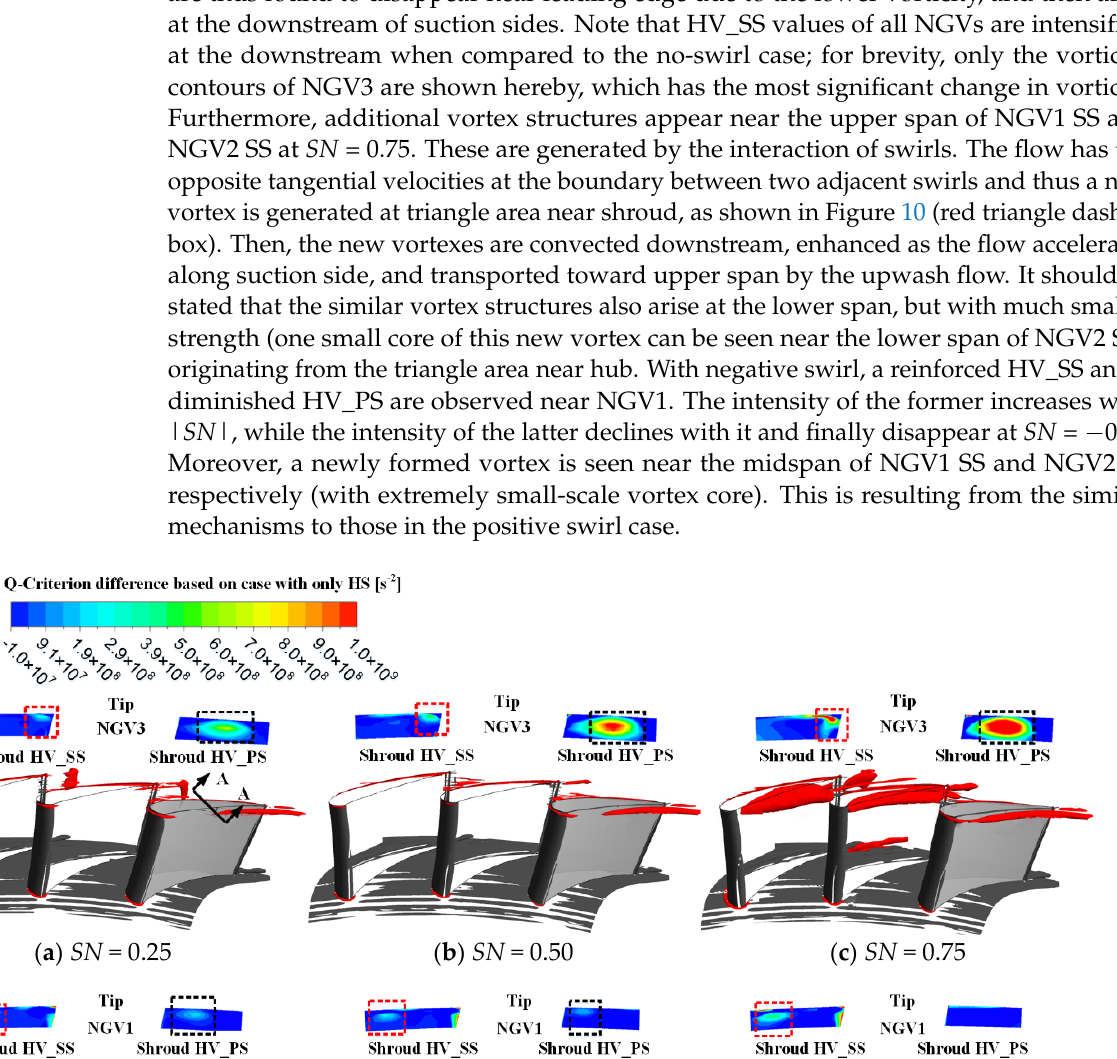
14 of 25 Figure 16. Vortex structure of case with only hot streak (iso-surface of Q-criterion, Q=1.5×10 8 s − 2 ). Compared to the no-swirl case, distinctive secondary flow structures are observed at